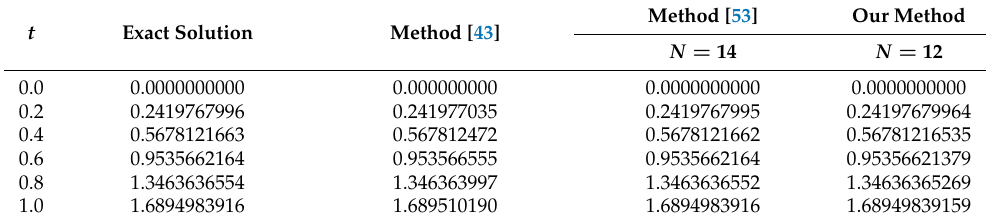
Table 6. Comparison of the MLG solution to the methods in [43,53] for ν = 1 and Example 5.